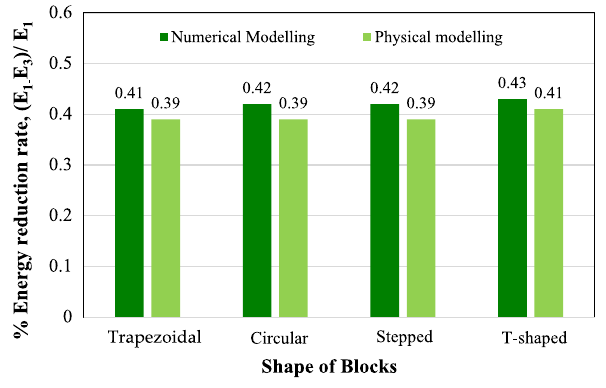
Fig. 20 Comparison of energy-reducing rates of numerical and physi- cal modeling for the single-row energy-dissipating blocks at maxi- mum design discharge of Q = 39.6